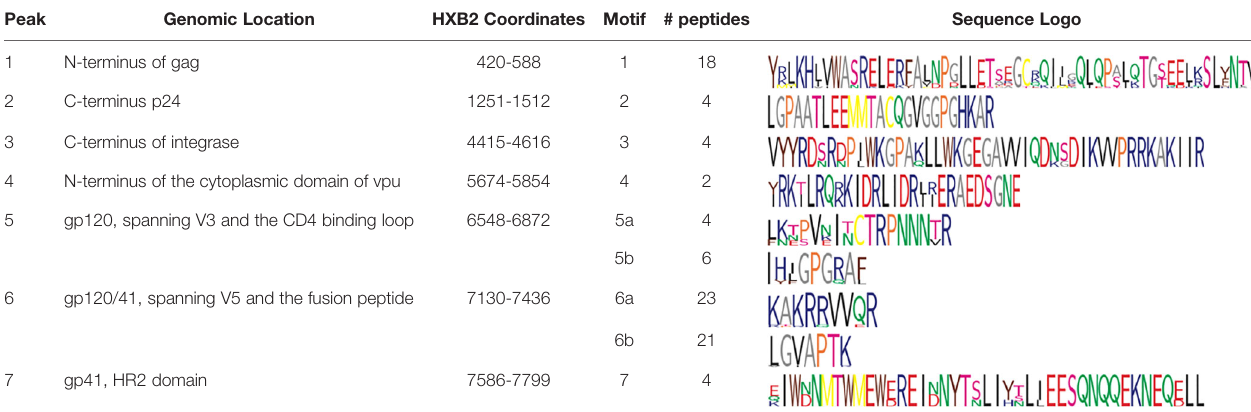
The table shows features of the 62peptides that had higher antibody reactivity in HIV controllers compared tonon-controllers who were virally suppressed on ART. The 62 peptides were